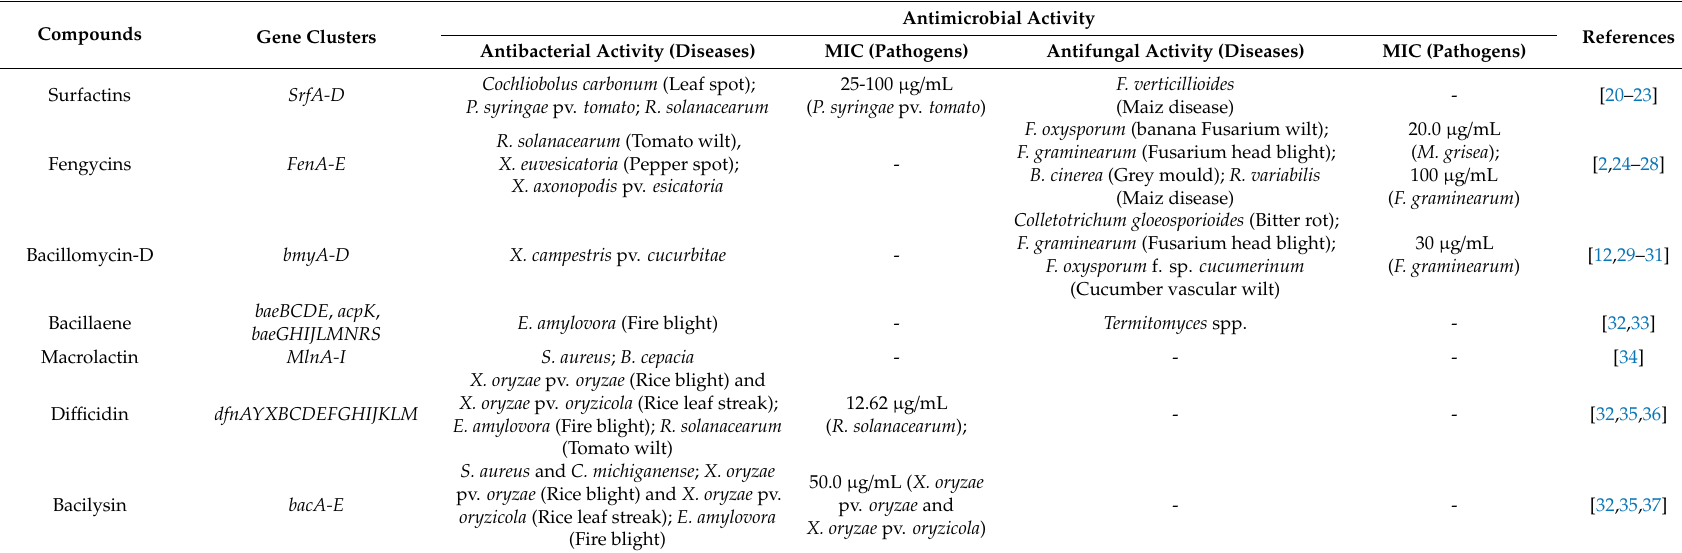
Table 1. Antimicrobial molecules synthesized by B . velezensis to control pathogenic